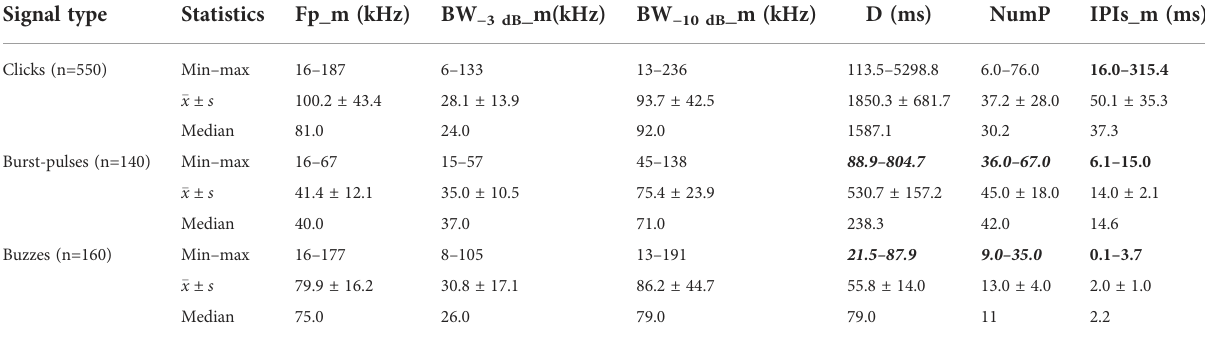
TABLE 3 Descriptive statistics for acoustic characteristics of train types produced by wild Indo-Paci fi c humpback dolphins in Beibu Gulf, South China Sea. Signal type